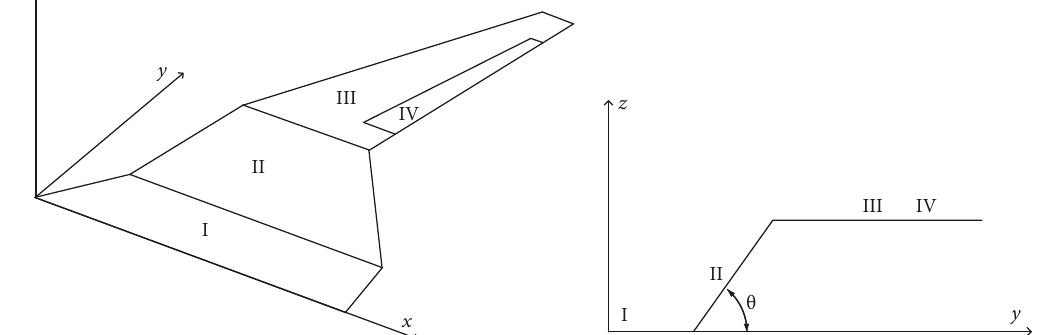
Figure 1: Sketch of a folding wing.